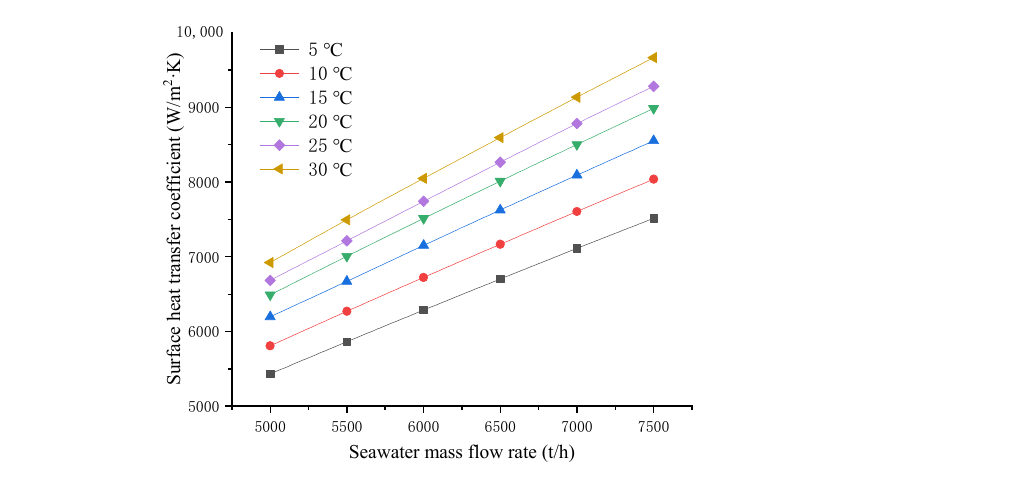
Figure 4. Surface heat transfer coefficient of the pipe side under different seawater temperatures and seawater flow rates.